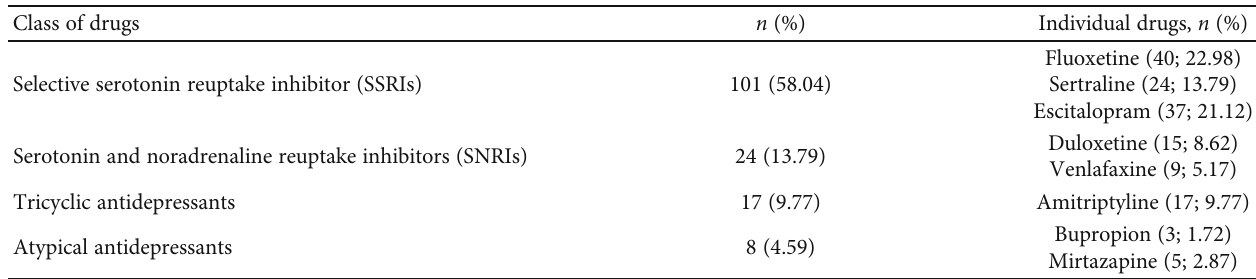
Table 2: Antidepressants prescribed as monotherapy ( n = 174 ).